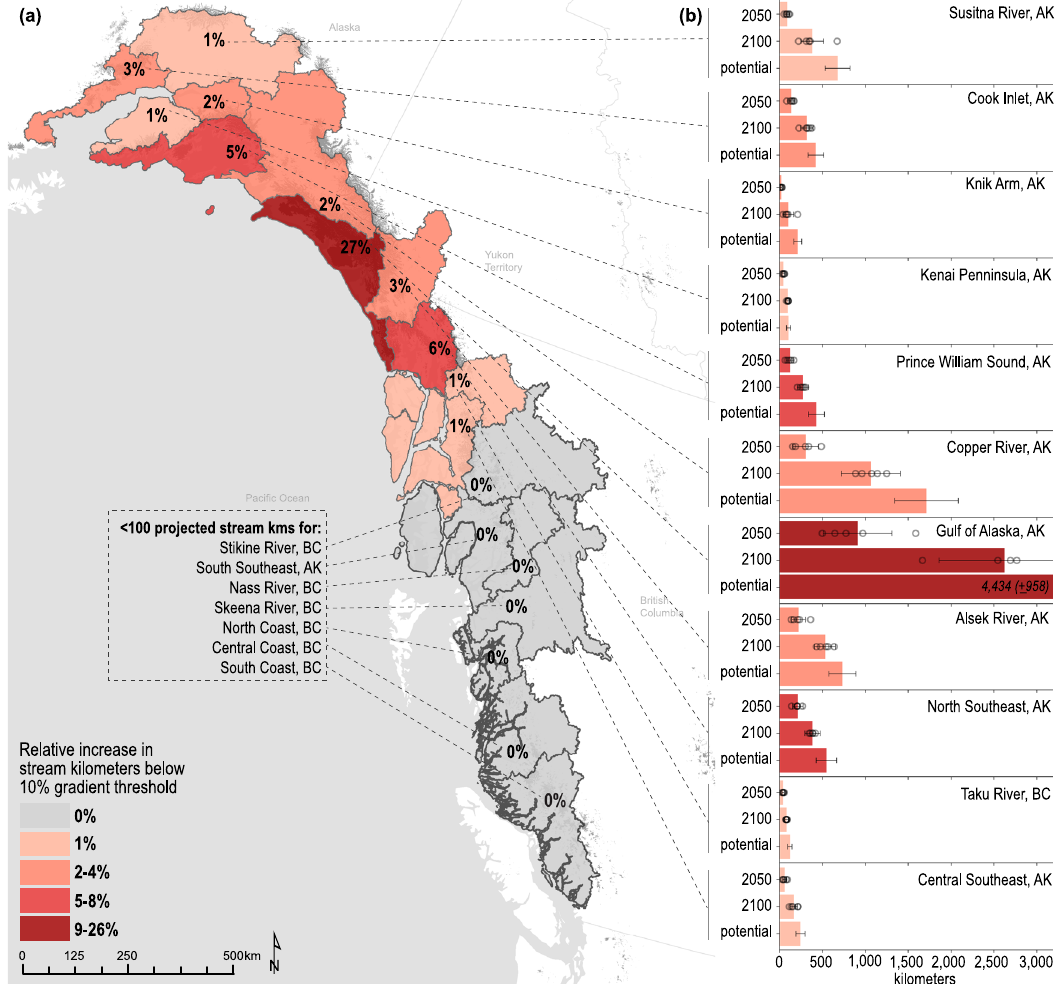
Fig. 2 Projected future salmon-accessible stream kms with <10% stream gradient migration threshold. a Map showing projected percent increase in future salmon-accessible stream kms, below a 10% stream gradient threshold for 2100, relative to present-day stream kms summed for each of the 18 sub- regions. Colors are de fi ned in map. Glacier retreat projections, in response to fi ve GCMs with RCP4.5 emission scenario, are used as an ensemble mean. b Bar plots representing ensemble-mean projected salmon-accessible stream kms with <10% stream gradient threshold for the years 2050, 2100, and potential complete deglaciation (i.e., once glaciers have retreated completely from the landscape) for each of the 18 sub-regions having >0% increase in future salmon-accessible stream kms. Projections are computed from 10-year averages centred ~2050 and 2100. Colors re fl ect percent increase values presented in A. Error bars correspond to ensemble-mean ± one standard deviation and originate from: GCM projections (RCP4.5, for 2050 and 2100), ice thickness estimates, and stream segment length (see Methods section “ Uncertainty estimates ’ ). Points represent projections for the individual GCMs for 2050 and 2100 ( N = 5). Projected future salmon-accessible stream kms (±one standard deviation) are presented in the Source Data